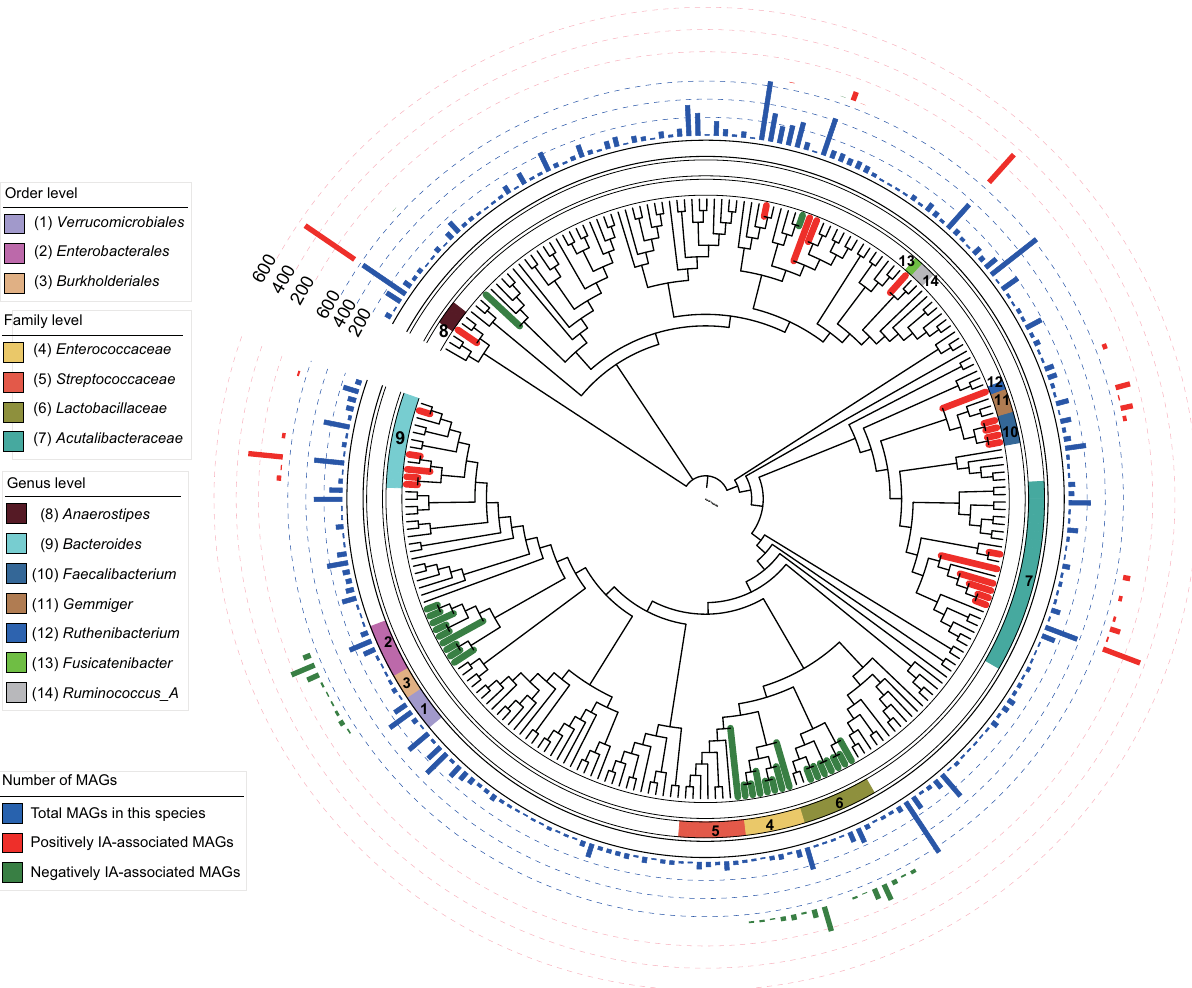
Fig. 4 Taxonomy distribution of MAGs positively or negatively associated with seroconversion. For clarity, the phylogenetic tree comprises only species containing more than 10 high-quality MAGs. The inner ring shows the total numbers of MAGs in each species in blue bars and the outer ring shows the numbers of positively IA-associated MAGs in red bars and negatively IA-associated MAGs in green bars. Branches of the phylogenetic trees are colored in red for taxa containing positively IA-associated MAGs and in green for taxa containing negatively IA-associated MAGs. Taxa are highlighted in arcs of varying colors and are identi fi ed in the legend. Comparative genomics were performed between adjacent taxa with and without signi fi cant MAGs. Source data are provided as a Source Data fi